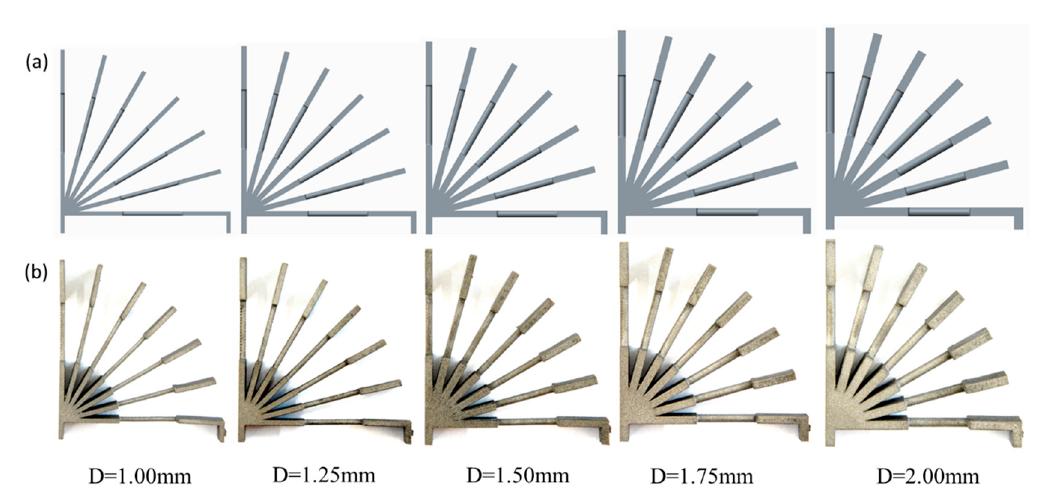
Figure 2. RA sample: ( a ) the CAD model of RA sample for rod diameter of 0.50–2.00 mm in increments of 0.25 mm and ( b ) RA Sample manufactured by SLM.